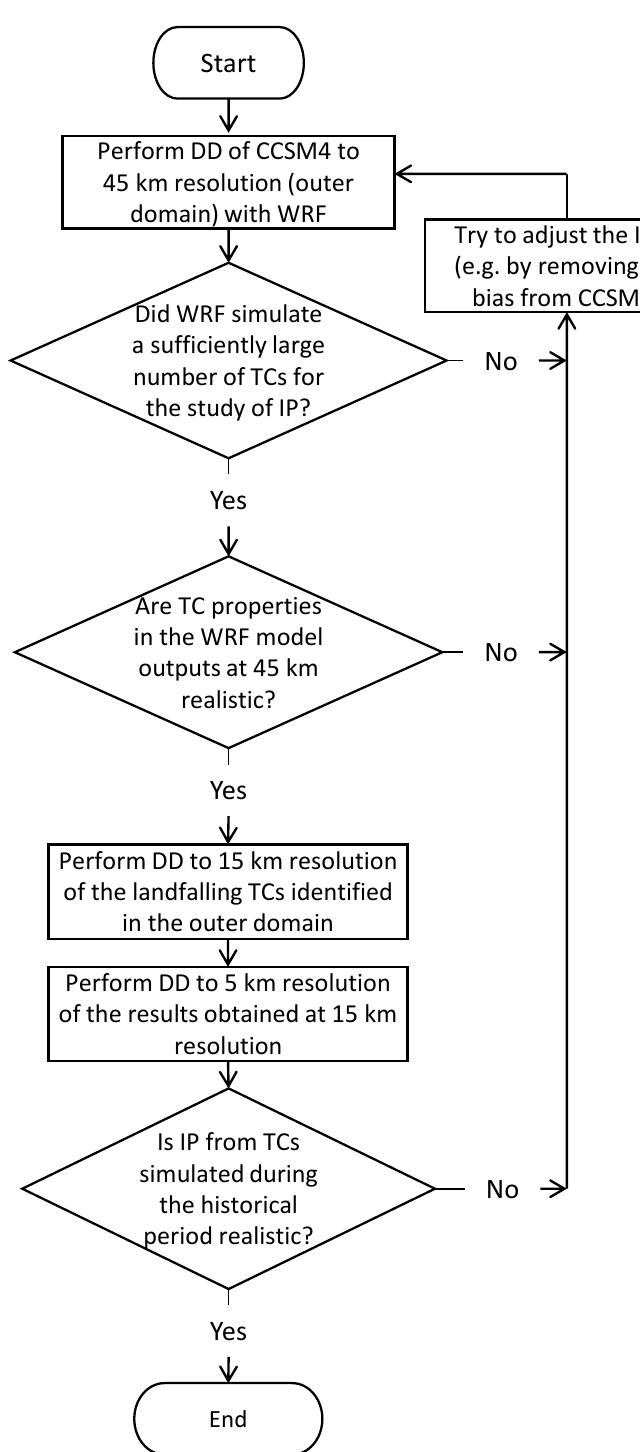
Figure 2. Flowchart of the steps for the DD of CCSM4 with WRF. IBC: initial and boundary condition, IP: intense precipitation, TC: tropical